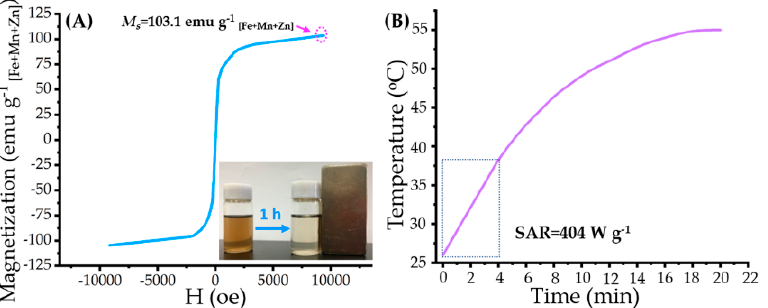
Figure 4. Magnetic property and magnetocaloric effect of MTNs: ( A ) magnetization curve of the MTN at 300 K; inset: photograph of MTN solution and its response to an external magnet at 1 h; ( B ) time-dependent temperature curve of MTN in AMF (corresponding parameters as 114 kHz of frequency and 63.6 kA m − 1 of strength) and corresponding SAR value.